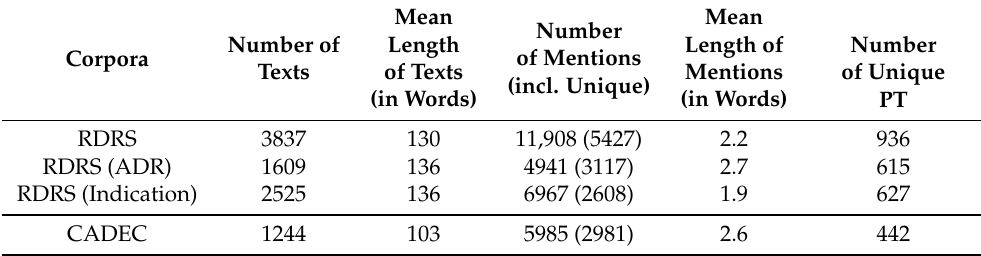
Table 1. Comparison of corpora datasets of Internet-user reviews in RDRS and in